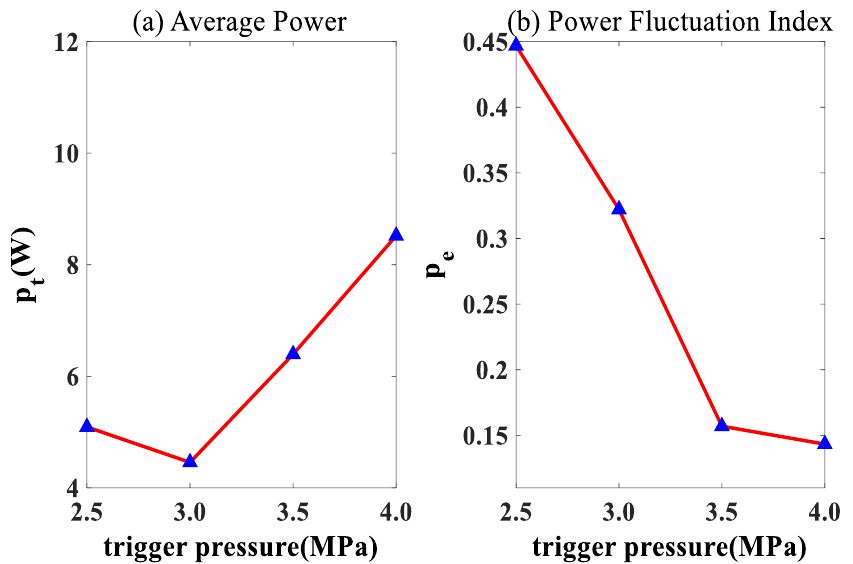
Figure 9. The average values of output power and power fluctuation index under different trigger pressure conditions.